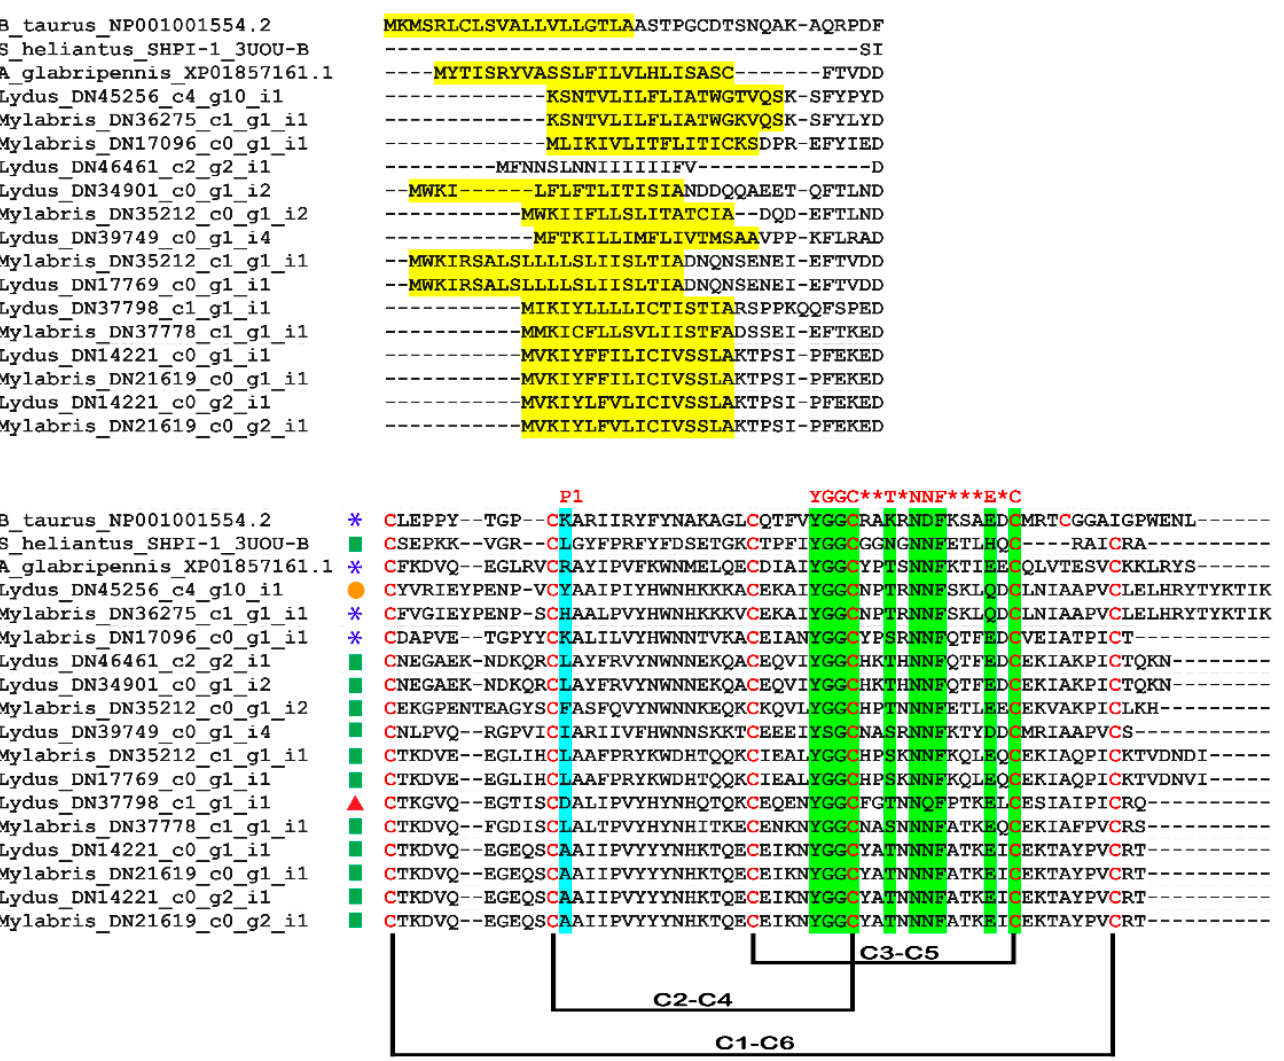
Figure 7. Alignment of Kunitz protein sequences (B_taurus_NP00100554.2, Bovine Pancreatic Trypsin Inhibitor; S_heliantus_SHPI-1_3UOU_B, Chain B, Kunitz-type protease inhibitor SHPI-1; A_glabripennis_XP01857161.1, Kunitz-type serine protease inhibitor 2-like of Anoplophora glabripennis . Upper panel: yellow, leader sequence. Lower panel: green, Kunitz family signature sequence; Red asterisks, any aminoacids in the signature sequence; blue, P1 site; blue asterisk, basic P1; green square, hydrophobic P1; orange circle, hydrophilic P1; red triangle, acidic P1; crosslinks, disulphide bridges.